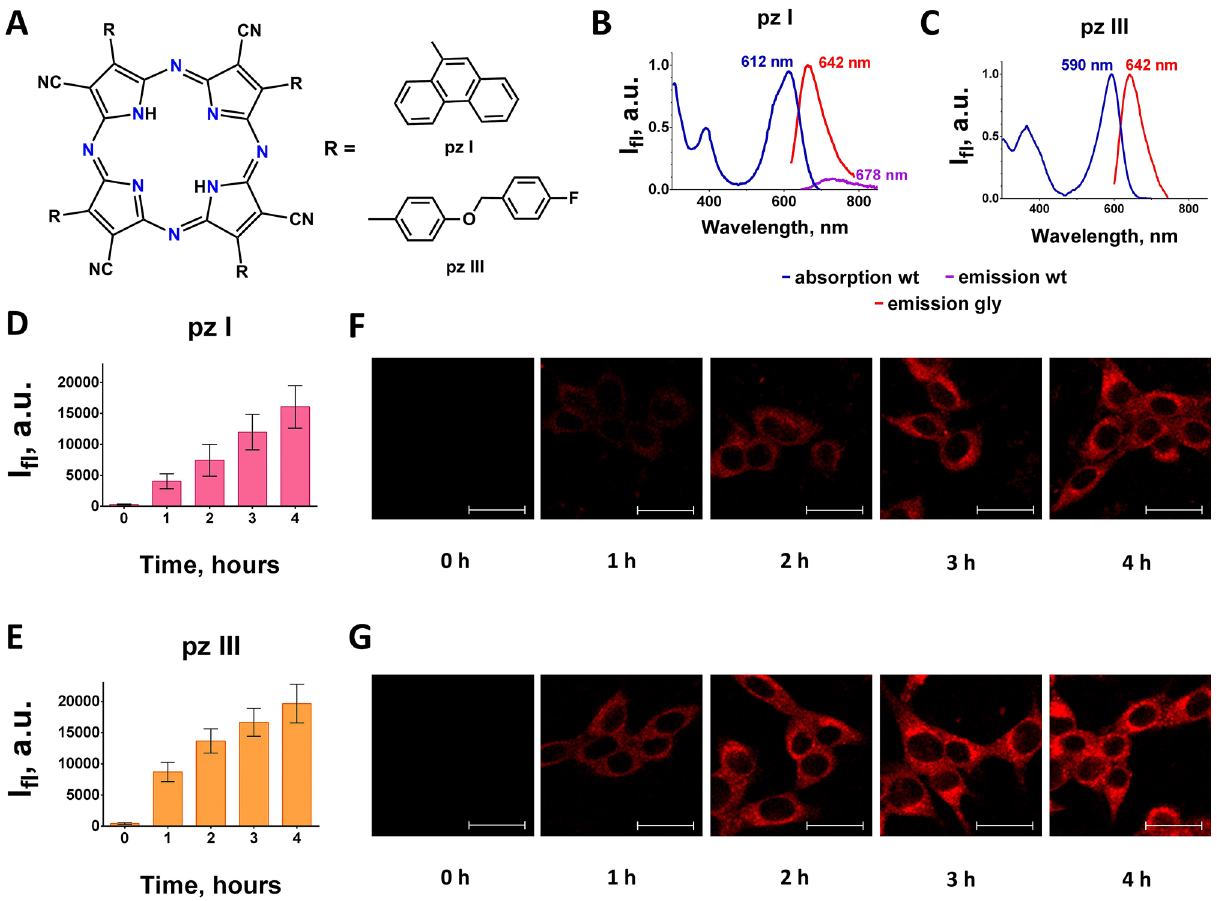
Figure 1. ( A ) Chemical structure of cyanoarylporphyrazines. ( B , C ) Fluorescence spectra and absorbance were obtained by spectrofluorometry for pz I ( B ) and pz III ( C ). Since pz I and pz III have a very low quantum yield of fluorescence in low-viscosity media (water), the pz I and pz III fluorescence was analyzed in a glycerol solution (in various ethanol:glycerol ratios). ( D, E ) Quantification of the fluorescence signal in fibrosarcoma MCA205 cells incubated with pz I or pz III expressed as mean ± SD (n = 5). The background intensity (Ifl) of the fluorescence signal before the addition of the photosensitizers did not exceed 0.3 a.u. ( F , G ) The uptake of pz I and pz III by fibrosarcoma MCA205 cells was quantified by confocal microscopy. The uptake was analyzed during up to 4 h of incubation with 10 μM of each photosensitizer. Images were acquired at λex 561 nm and λ em 600–700 nm; scale bars 20 μm.